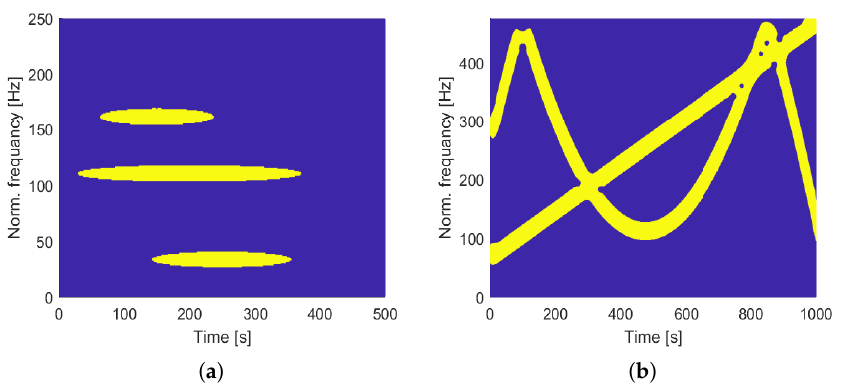
Figure 7. Ideal useful content extraction for two signals. ( a ) Useful information content for the first signal. ( b ) Useful information content for the second signal.